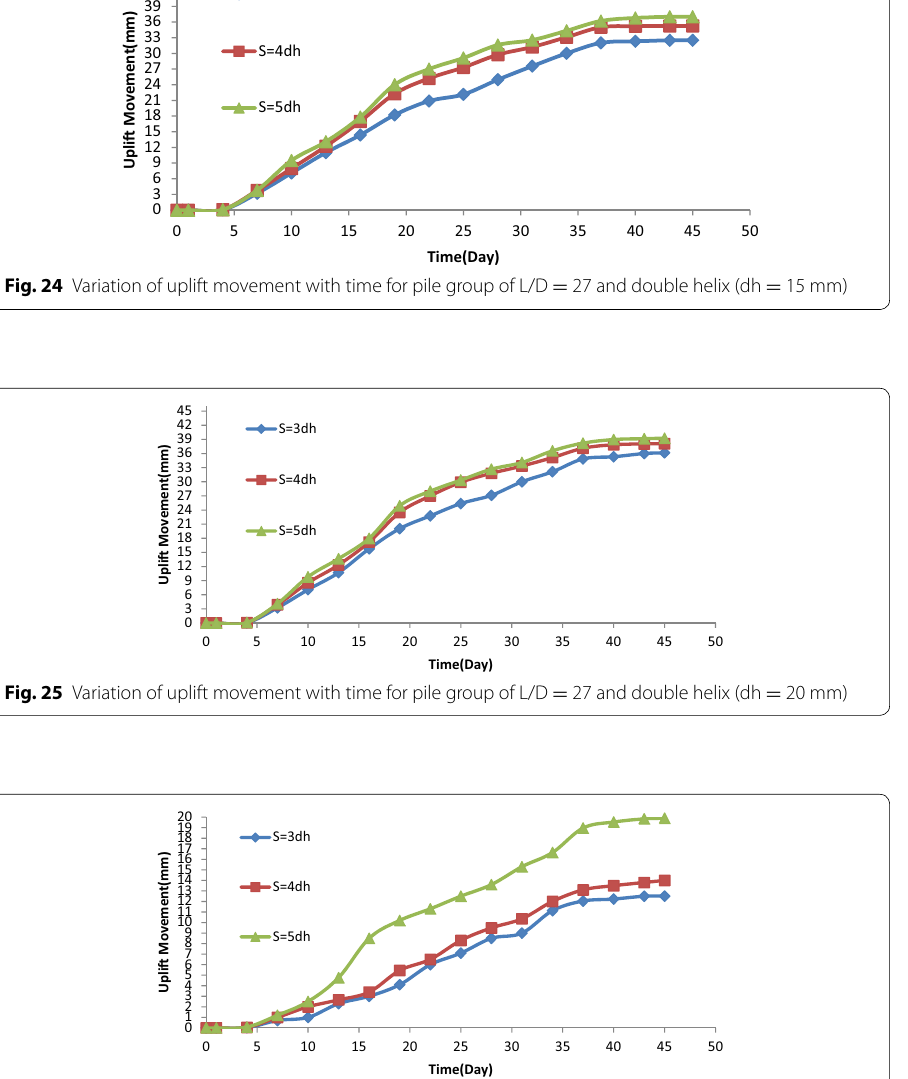
35 and single helix (dh =